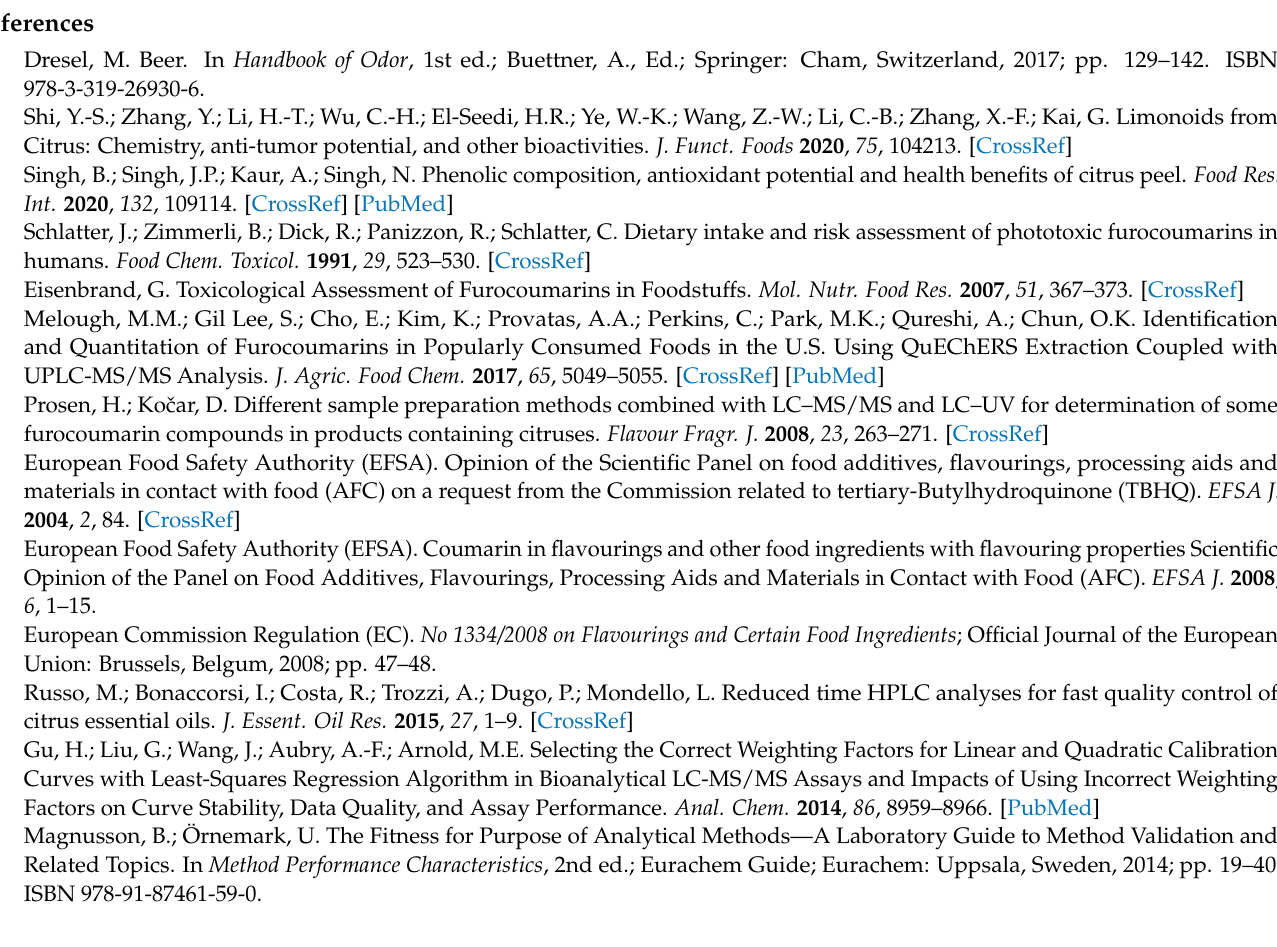
Figure S2: Influence of time on SPME method extraction optimization; Figure S3: Influence of sample volume on SPME method extraction optimization; Figure S4: Influence of sample time conditioning on SPME method extraction optimization; Figure S5: Influence of stirring rate on SPME method extraction optimization; Figure S6: Influence of NaCl addition on SPME method extraction optimization; Figure S7: Comparison between volatile profile of sample 1 (in blue) and sample 1 spiked with 1.8% lemon peel (in red); Figure S8: Comparison between volatile profile of sample 1 (in blue) and sample 1 spiked with 1.5% orange peel (in red); Figure S9: Comparison between volatile profile of sample 1 (in blue) and sample 1 spiked with 0.3% bergamot E.O. (in